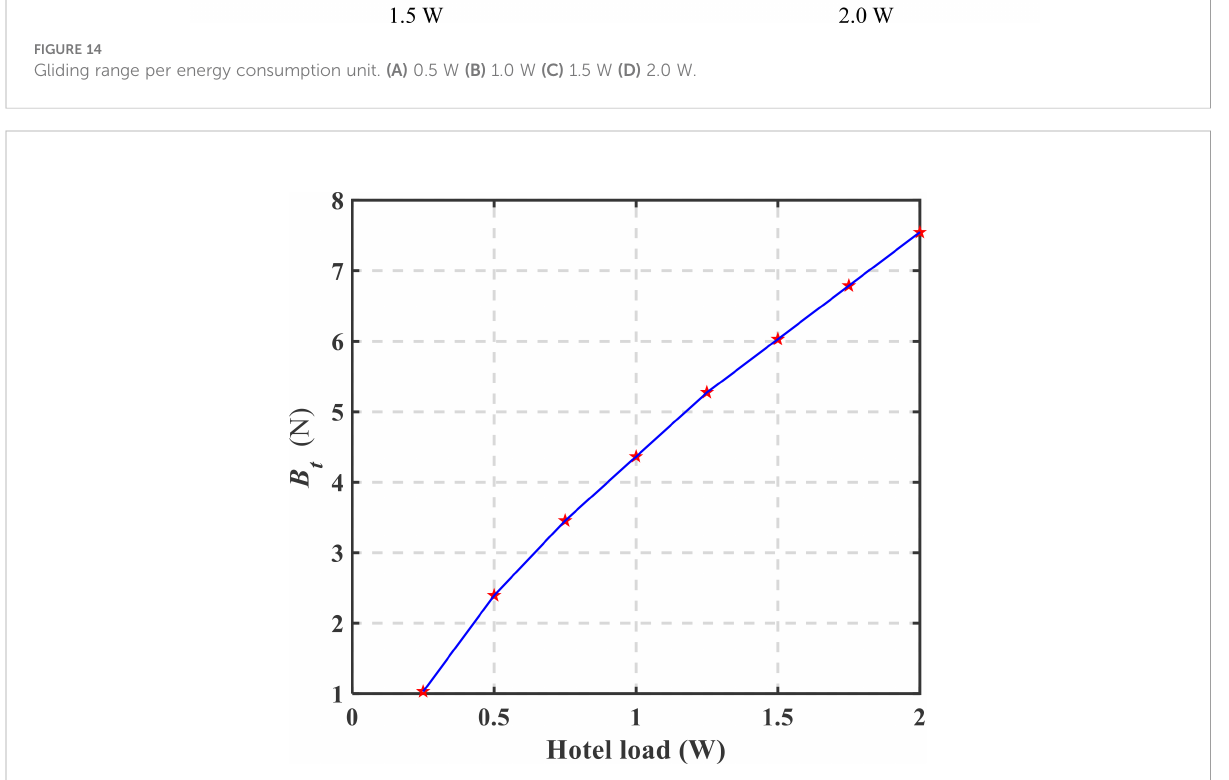
FIGURE 15 Variation of B t with hotel